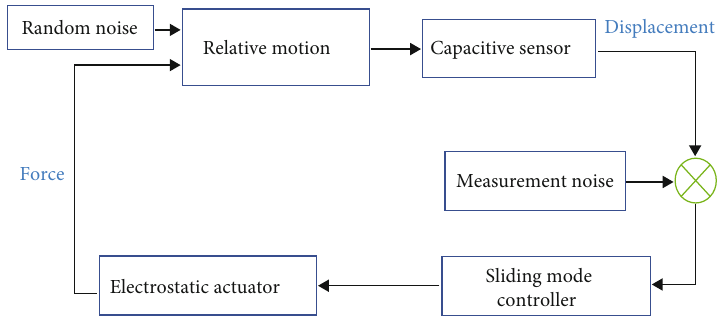
Figure 7: The structure of the control system. Table 2: The control